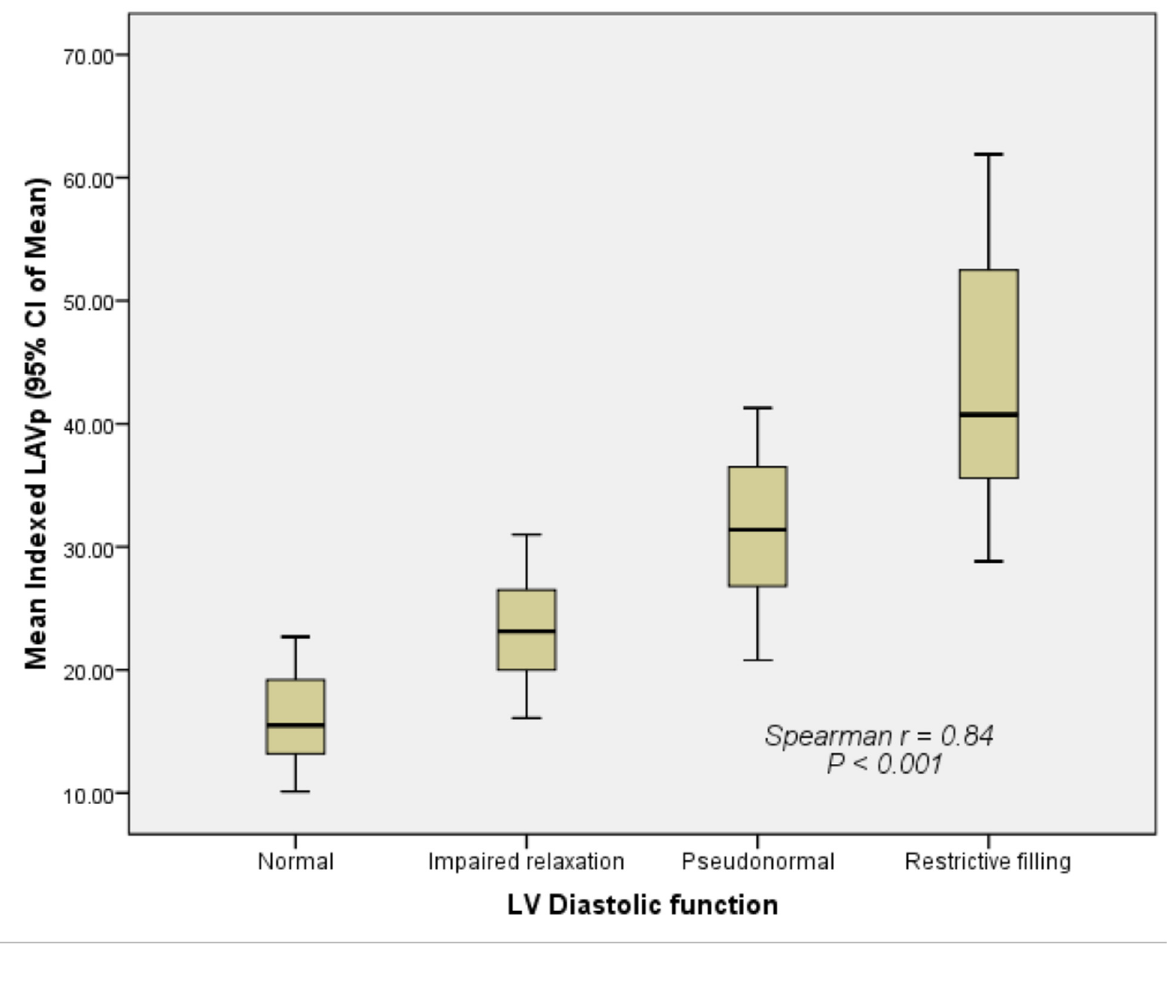
Fig 5. Correlation between the indexed LAVp and different grades of left ventricular diastolic dysfunction. The indexed LAVp increased significantly as LV diastolic dysfunction decreased ( P <